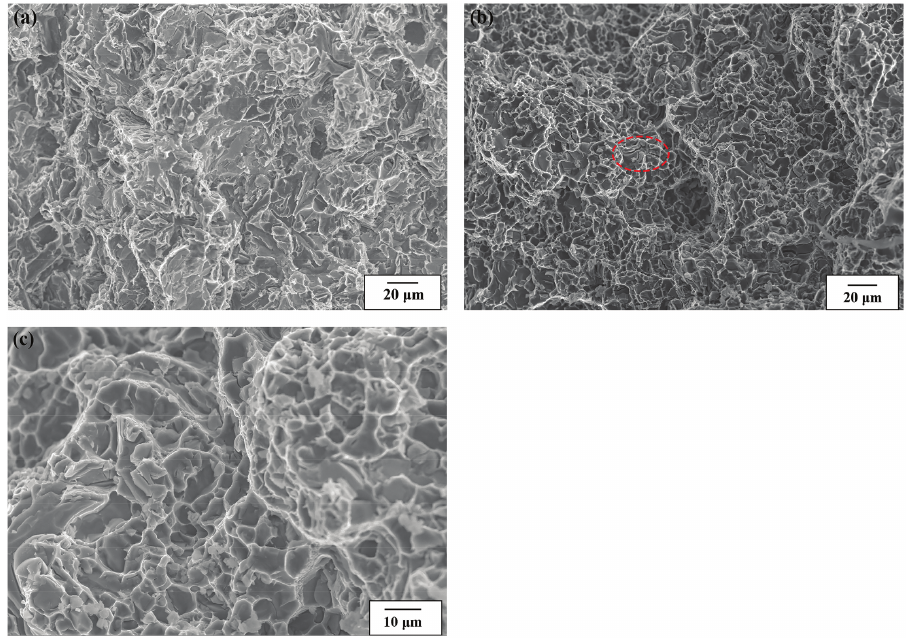
Figure 6: SEM micrograph showing the tensile fracture of Al-Si-Cu-Mg alloys (a) as-cast alloy; (b-c) aging-treated alloy.